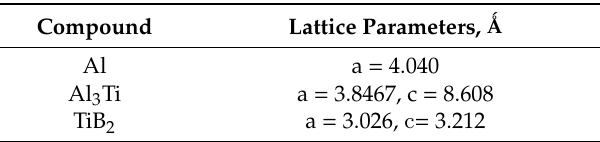
Figure 10. Typical X-ray diffraction (XRD) pattern of the planetary milled Al–Ti–B-based combustion 146 product. 147 Table 5. XRD-analysis results of synthesized products based on the planetary milled Al-Ti-B mixture. Table 7. Lattice parameters of Al, Al 3 Ti, amd TiB 2 phases. Compound Lattice Parameters,